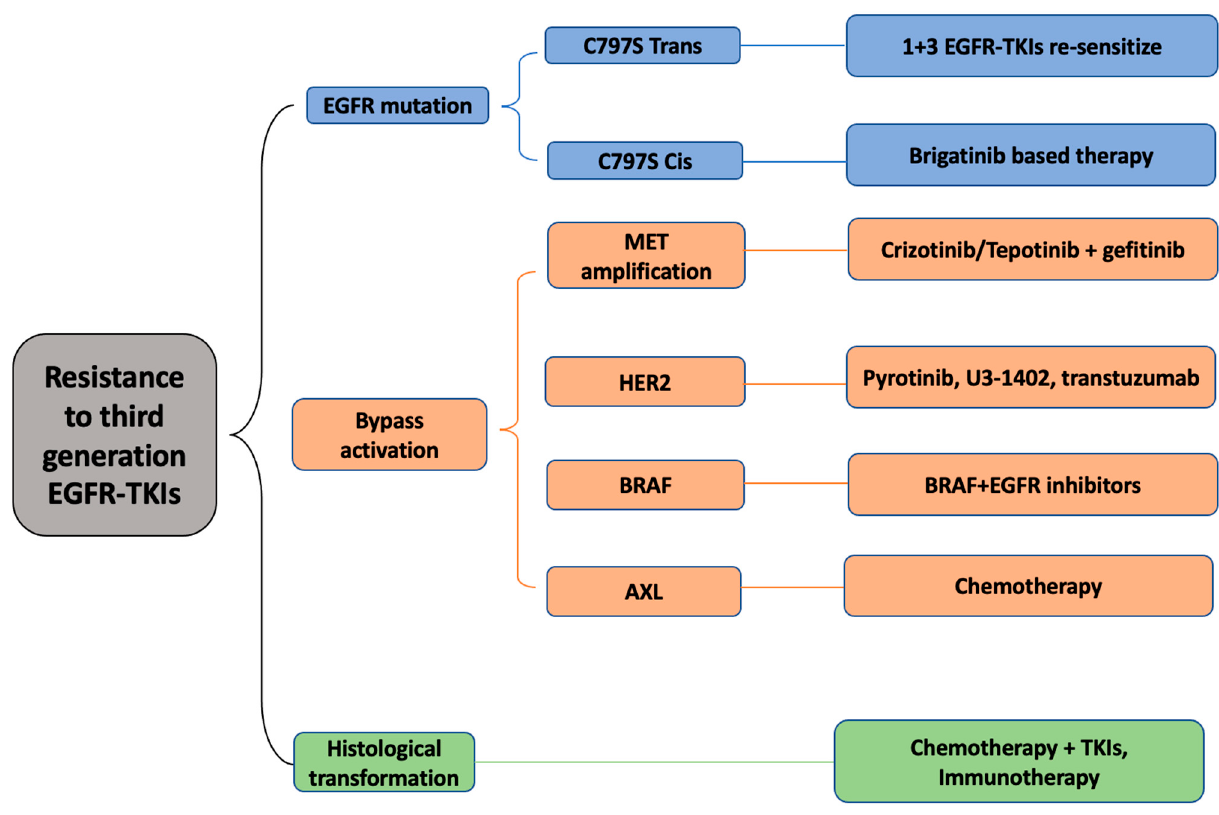
Figure 2. ( A ) Major resistance mechanism after EGFR-TKIs therapy. ( B ) Management strategies for different types of resistance.